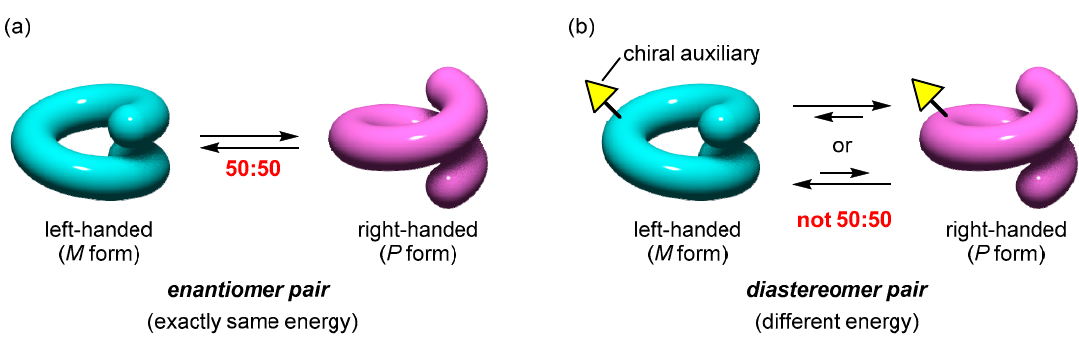
Figure 3. Equilibrium between P and M forms and their energy differences. ( a ) Enantiomer pair, ( b ) diastereomer pair.